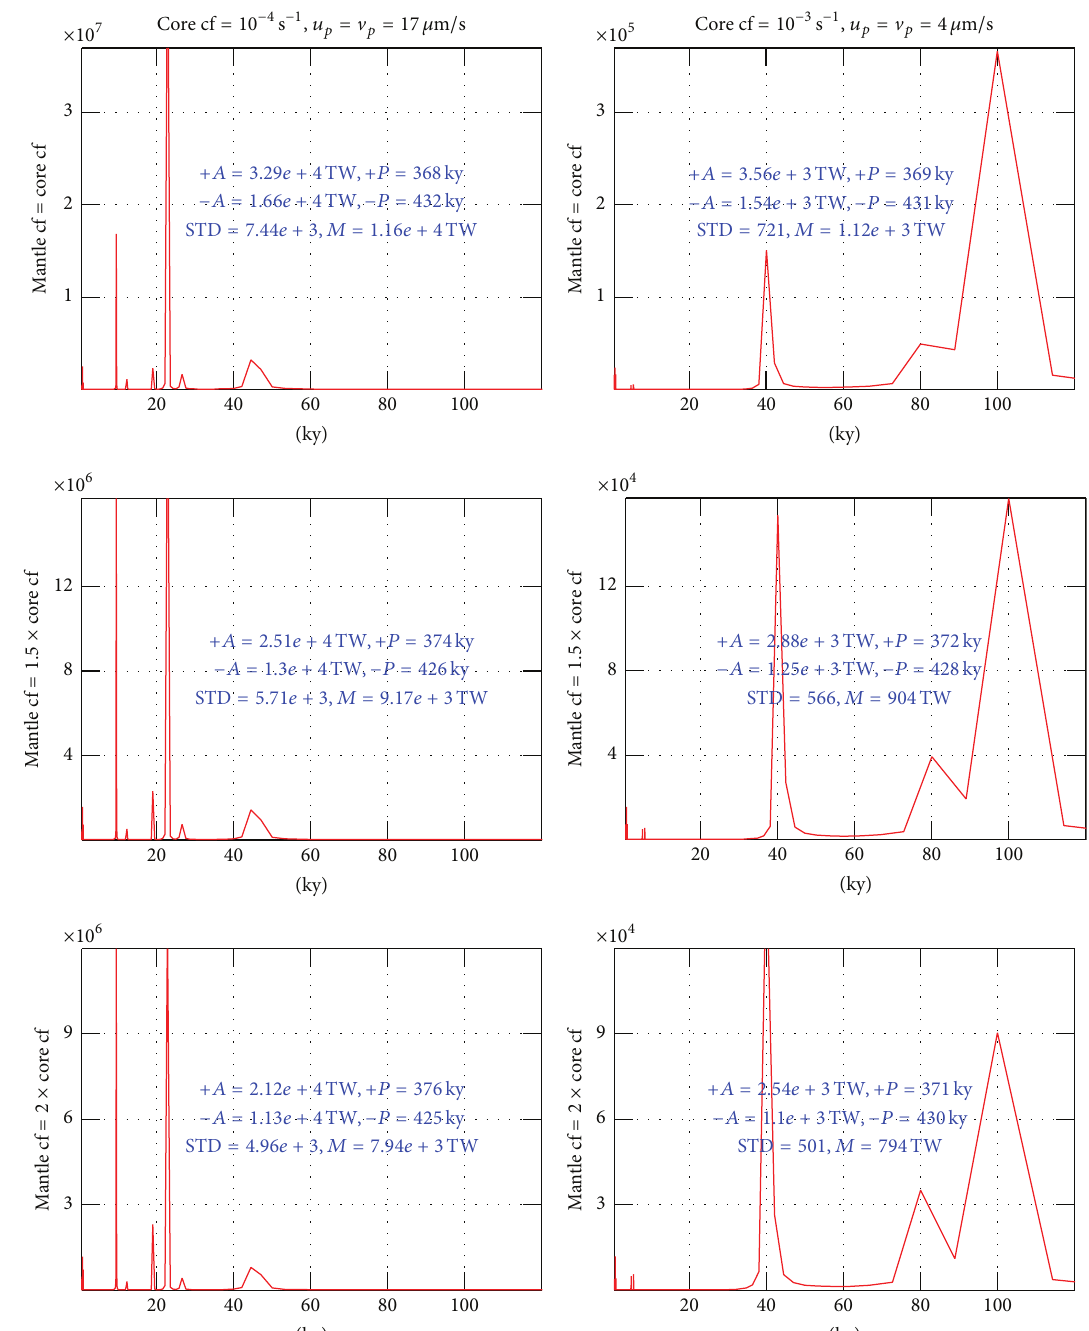
Figure 3: Squared-amplitude spectra for the total PSMGIM time series (TW 2 ). The experimental dissipation coefficient for magma within the outer core was set at 10 −4 (left column) and 10 −3 s −1 (right column) and enlarged by 100% (Row 1), 150% (Row 2), and 200% (Row 3) for magma within the lower mantle. The total PSMGIM time series (not plotted) was 100% and was correlated with its reconstruction via the Discrete Fourier Transform (DFT) with a confidence of 99.99% and was evaluated using the following: (1) the maximum size of the positive/negative amplitude of its anomaly (“ +𝐴/ − 𝐴 ”), (2) the total phase length during positive-/negative-anomaly phases (“ +𝑃/ − 𝑃 ”), (3) the standard deviation (“STD”), and (4) the mean (“ 𝑀 ”). Parameters 𝑘𝑓 , 𝑢 𝑞 , and V 𝑞 are described in Section